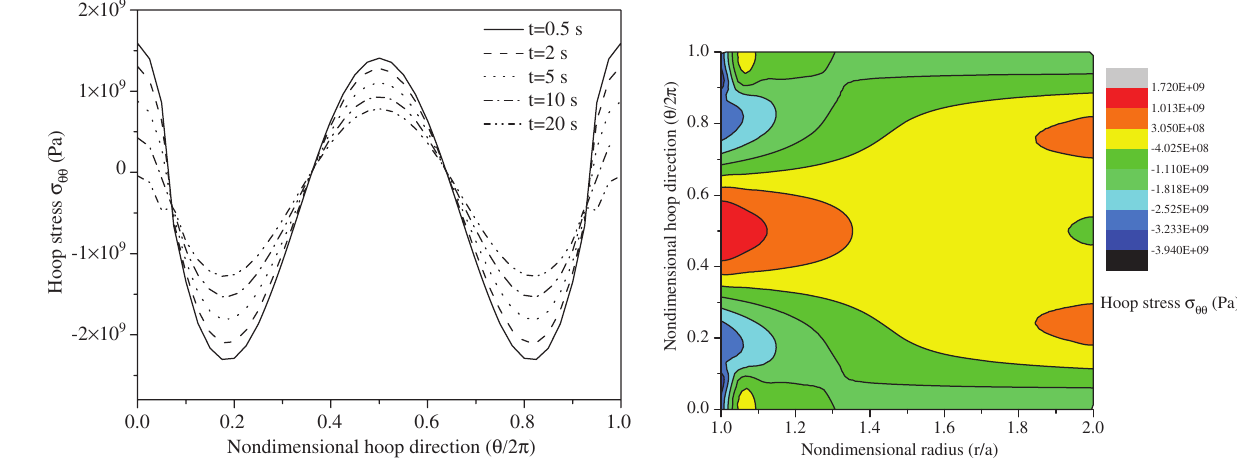
Figure 24 Contour map of hoop stress in the FGM hollow cylinder, where t = 0.5